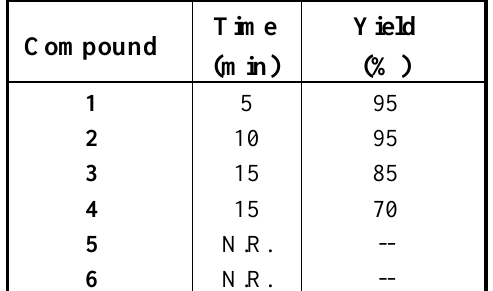
Table 4. Solid phase oxidation of benzoins on silica gel under microwave